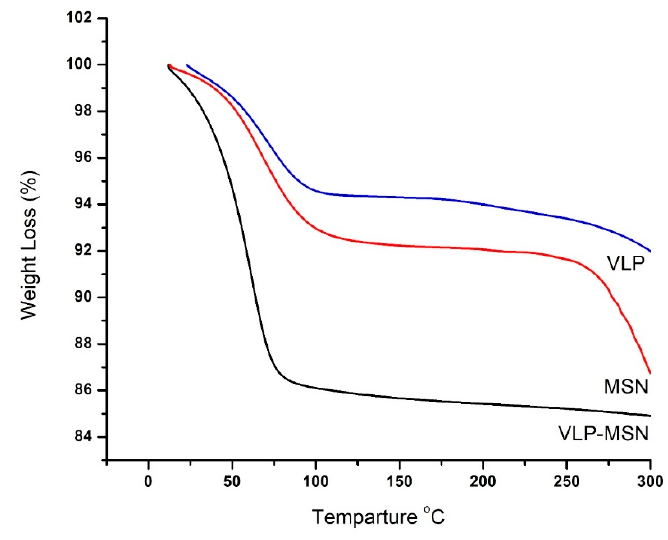
Figure 5. TGA thermograms of VLP, MSN and VLP-MSN.